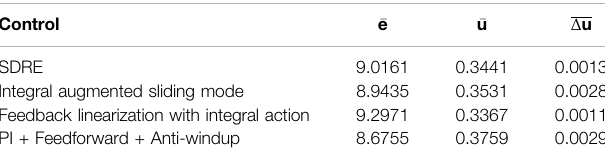
TABLE 1 | Performance of control strategies: simulation results for square wave with T = 2